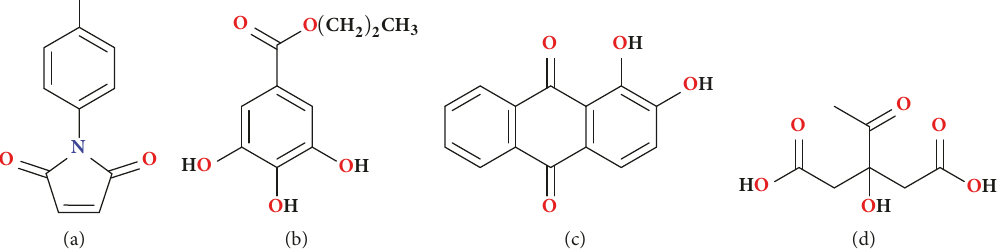
Figure 1: Chemical structures of (a) maleimide ( p -CH 3 ), (b) propyl gallate (PG), (c) alizarin (ALZ), and (d) citric acid